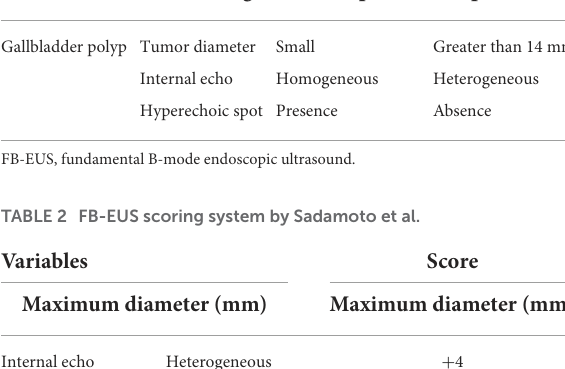
TABLE 1 Characteristic findings of gallbladder polyps in FB-EUS.